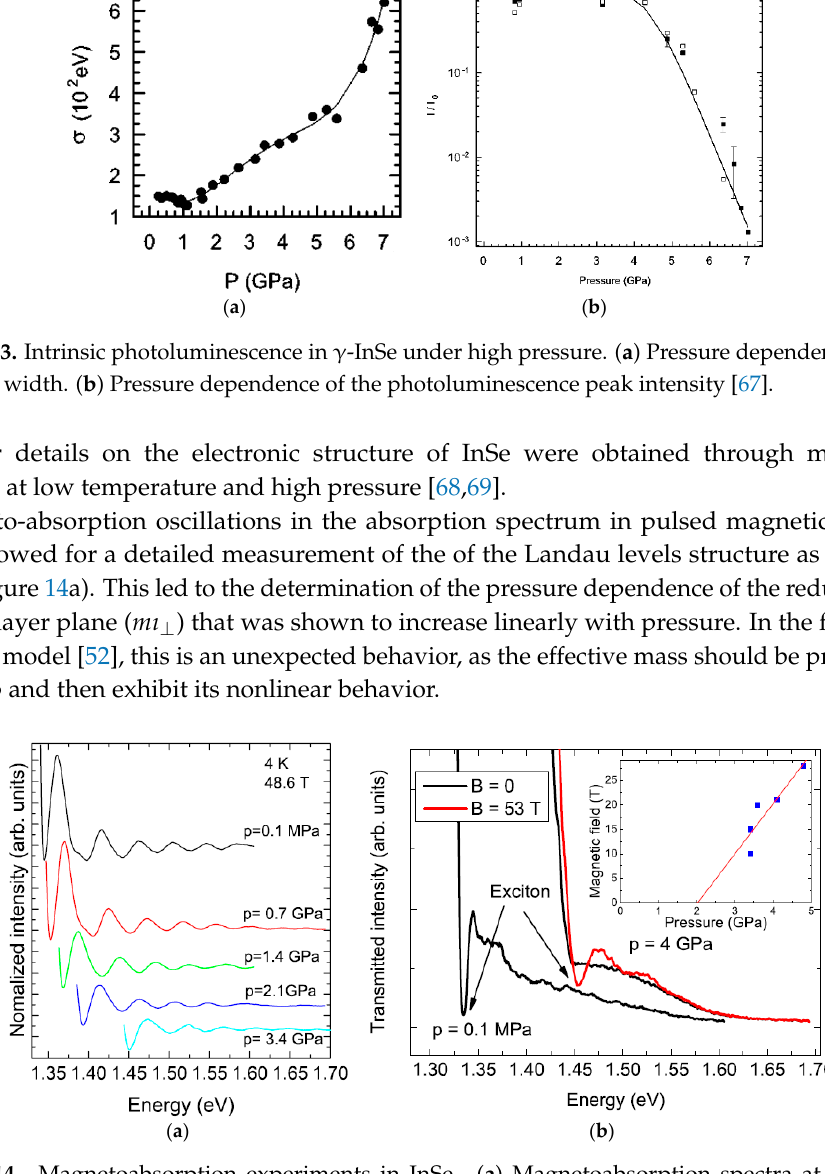
Figure 14. Magnetoabsorption experiments in InSe. ( a ) Magnetoabsorption spectra at different pressures. ( b ) Reemergence of the exciton peak at 4 GPa under high magnetic field. Inset: magnetic field at which the exciton peak reappears as a function of pressure